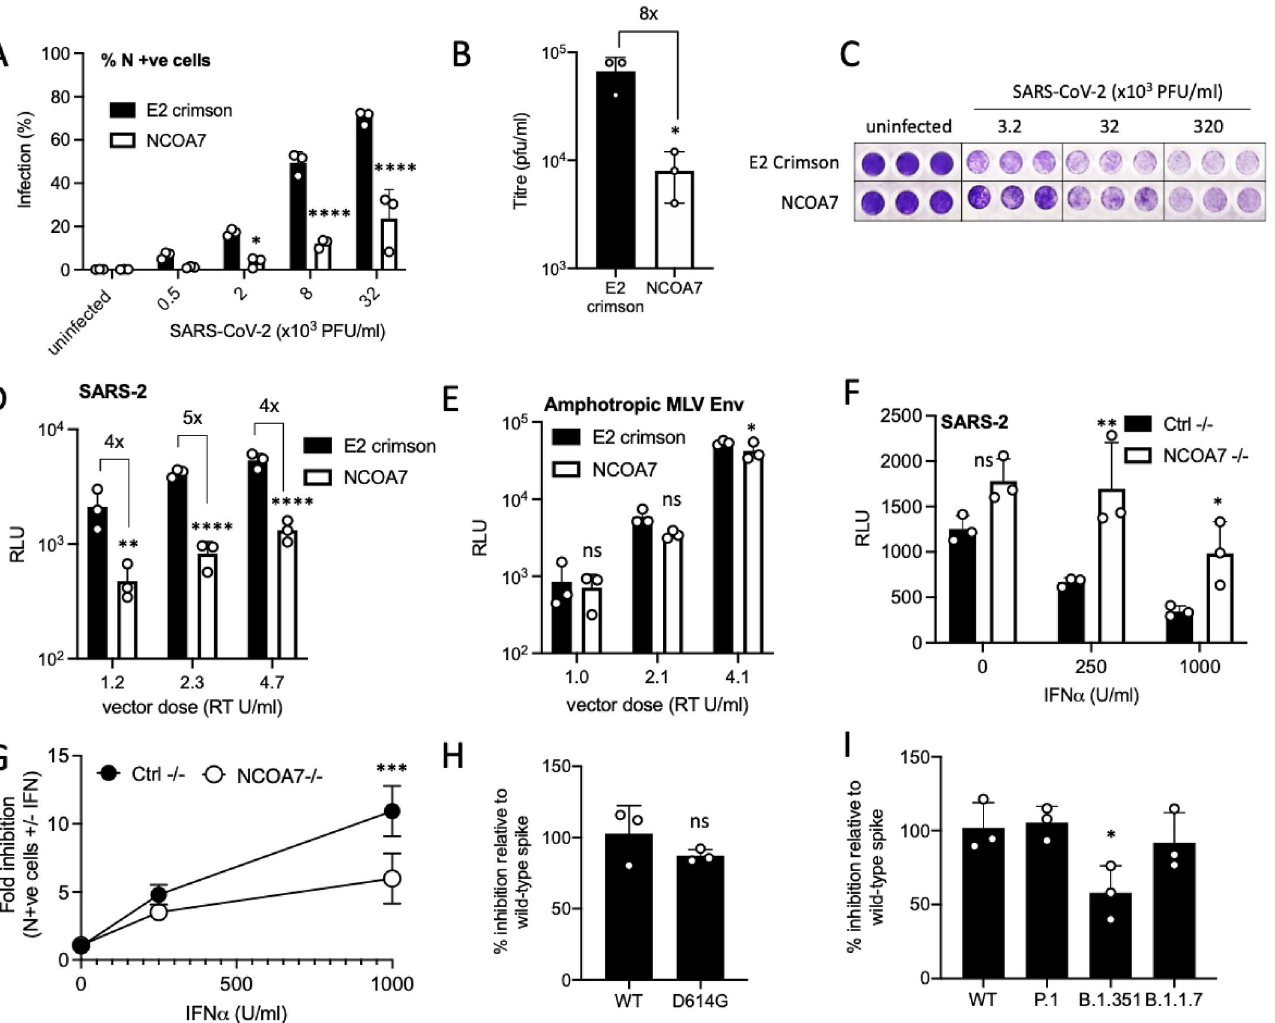
Fig 1. NCOA7 inhibits SARS-CoV-2 infection. (A) A549-ACE2 cells expressing E2crimson or NCOA7 were infected with replication-competent SARS-CoV-2 for 48 h. Nucleocapsid positive cells were enumerated by flow cytometry. (B) VeroE6 cells were incubated for 72 h with supernatants from A549-ACE2 cells expressing E2crimson or NCOA7 infected with replication-competent SARS-CoV-2 for 48 h. Plaque forming units were counted to calculate the titre. (C) Crystal violet staining of A549-ACE2 cells expressing E2crimson or NCOA7 after infection with replication competent SARS-CoV-2 for 72 h. (D) A549-ACE2 cells expressing E2crimson or NCOA7 were infected with SARS-CoV-2 Spike pseudotyped vector expressing luciferase. Luciferase activity was measured 48 h post- infection. (E) A549-ACE2 cells expressing E2crimson or NCOA7 were infected with Amphotropic MLV envelope pseudotyped vector expressing luciferase. Luciferase activity was measured 48 h post-infection. (F) A549-ACE2-Cas9 cells were transduced with lentiviral vectors expressing CRISPR non-targeting guide RNA (Ctrl-/-) or guide RNA targeting NCOA7. Treated with IFN- α for 24 h before challenge with SARS-CoV-2 Spike pseudotyped vector expressing luciferase. Luciferase activity was measured 48 h post-infection. (G) A549-ACE2-Cas9 cells were transduced with lentiviral vectors expressing CRISPR non-targeting guide RNA (Ctrl-/-) or guide RNA targeting NCOA7. Treated with IFN- α for 24 h before challenge with replication-competent SARS-CoV-2. Nucleocapsid positive cells were enumerated by flow cytometry 48 h post-infection. (H) A549-ACE2 cells expressing E2crimson or NCOA7 were infected with wild-type (WT) or D614G SARS-CoV-2 Spike pseudotyped vectors expressing luciferase. Luciferase activity was measured 48 h post-infection. (I) A549-ACE2 cells expressing E2crimson or NCOA7 were infected with wild-type (WT), P.1, B.1.351 or B.1.1.7 SARS-CoV-2 Spike pseudotyped vectors expressing luciferase. Luciferase activity was measured 48 h post-infection. For all the data n = 3, mean +/- SD. (A, D-G) analysed using two-way ANOVA. (B, H) analysed using unpaired t-test. (I) analysed using one- way ANOVA. � (p < 0.05), �� (p < 0.01), ��� (p < 0.001), ���� (p <